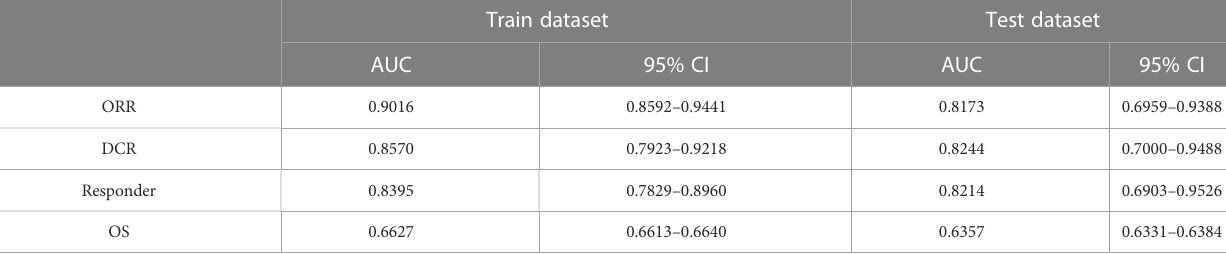
TABLE 2 The performance of immunotherapy ef fi cacy predictive tool.